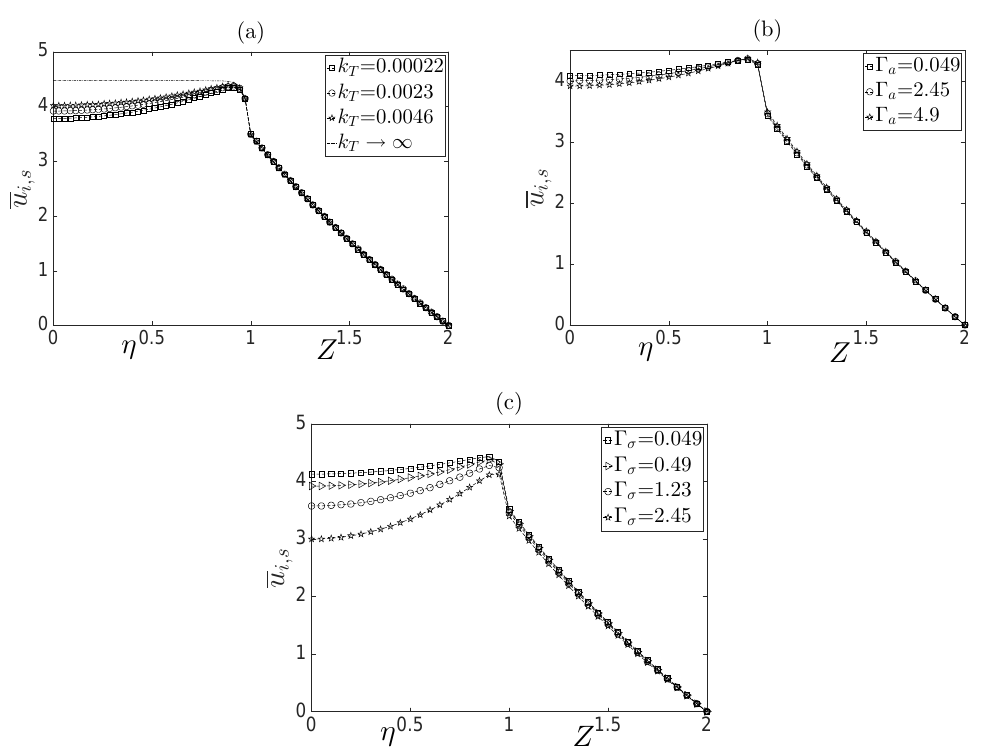
Figure 4. Dimensionless velocity profiles for the inner and surrounding fluids as a function of the dimensionless radial coordinates η and Z . ( a ) Effect of the parameter k T ; ( b ) effect of the parameter Γ a ; ( c ) effect of the parameter Γ σ